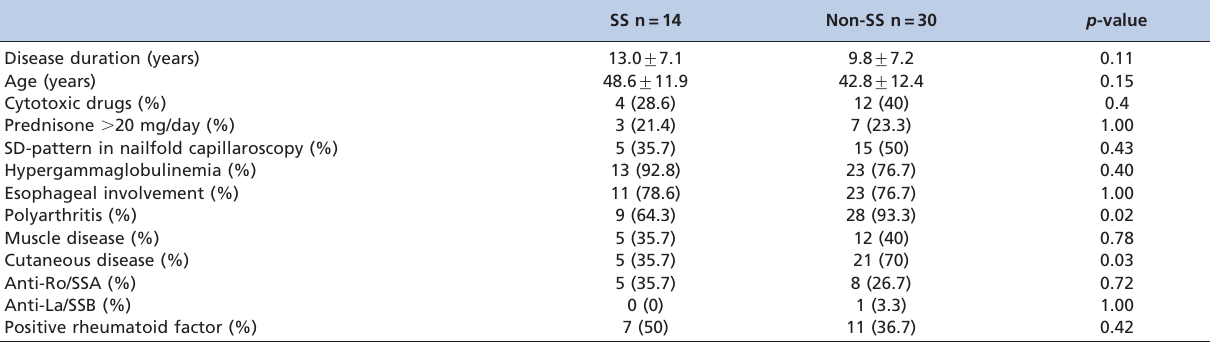
SS n=14 Non-SS n=30 p -value